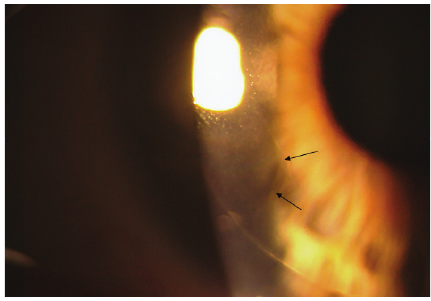
Figure2:Delimitation(blackarrows)oftheloosecornealtissuethat was present in the nasal quadrant and evidenced after lifting the flap.